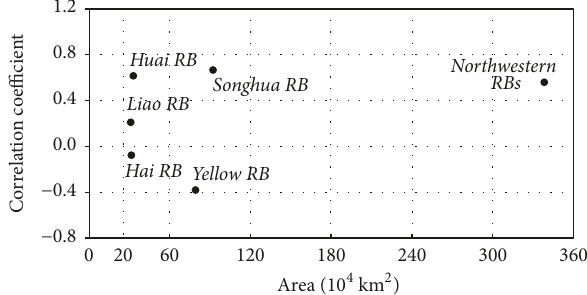
Figure 4: The relationship between correlation coefficient and area in six river basins of Northern China (see Figure 1 for the number of the river